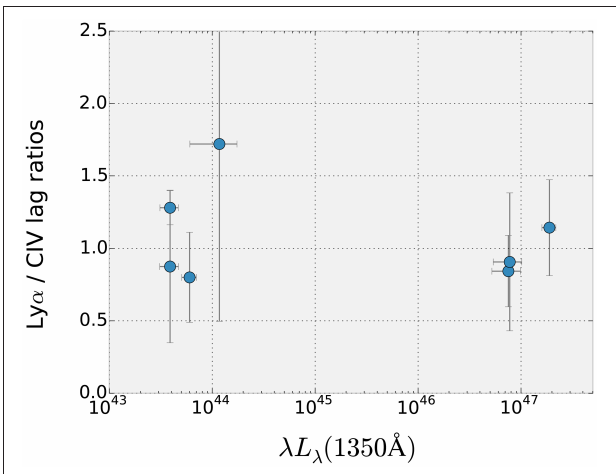
FIGURE 4 | Ly α to CIV lag ratios as a function of the λ L λ (1345Å) luminosity